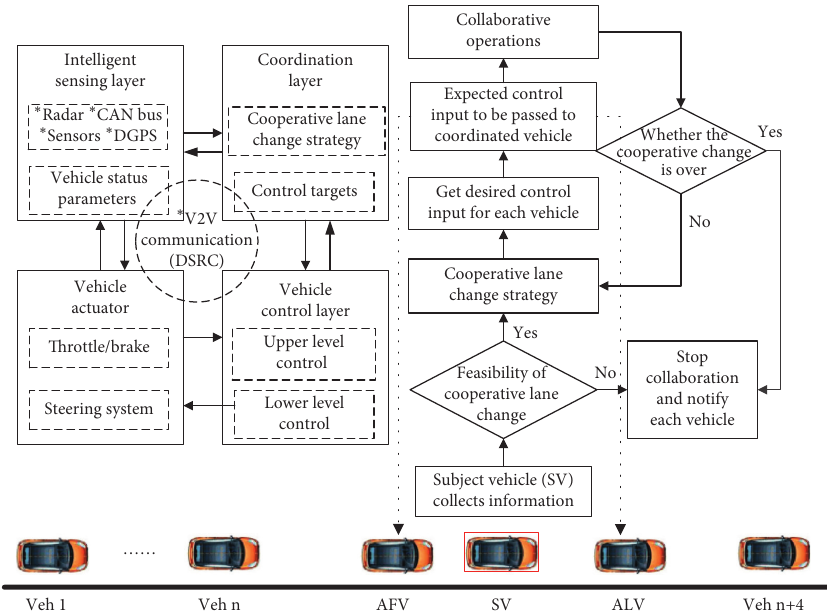
Figure 1: Multivehicle coordinated lane-change system architecture and workflow.